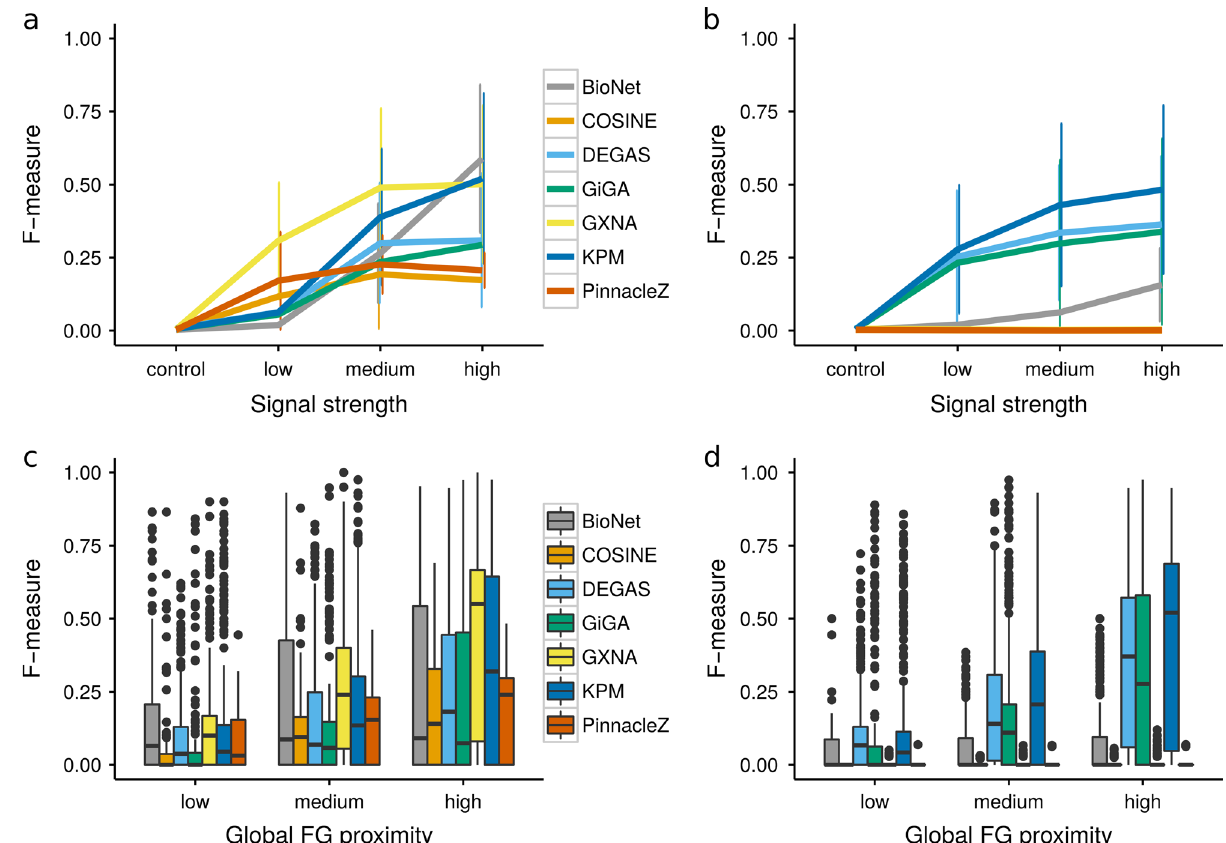
Fig. 2 Average performance for over 80 FG sets of size 20 nodes were generated, using the AVD k algorithm, with varying signal strength ( a , b ) and varying sparsity ( c , d ). Expression pro fi les were simulated with varying mean (VM) ( a , c ) and varying variation (VV) ( b , d ). The HPRD network was used as the input network and the performance was assessed using the F-measure. The error-bars ( a , b ) and box plots ( c , d ) represent performance over several FG nodes and over a range of internal parameter settings for each tool. The higher the signal strength, the more different are the expression pro fi les of the FG vs. BG genes, indicating that we can expect pathway enrichment methods to identify them more easily. For details on internal parameters, signal strength and sparsity values, please refer to Supplementary Tables 1, 3, 5